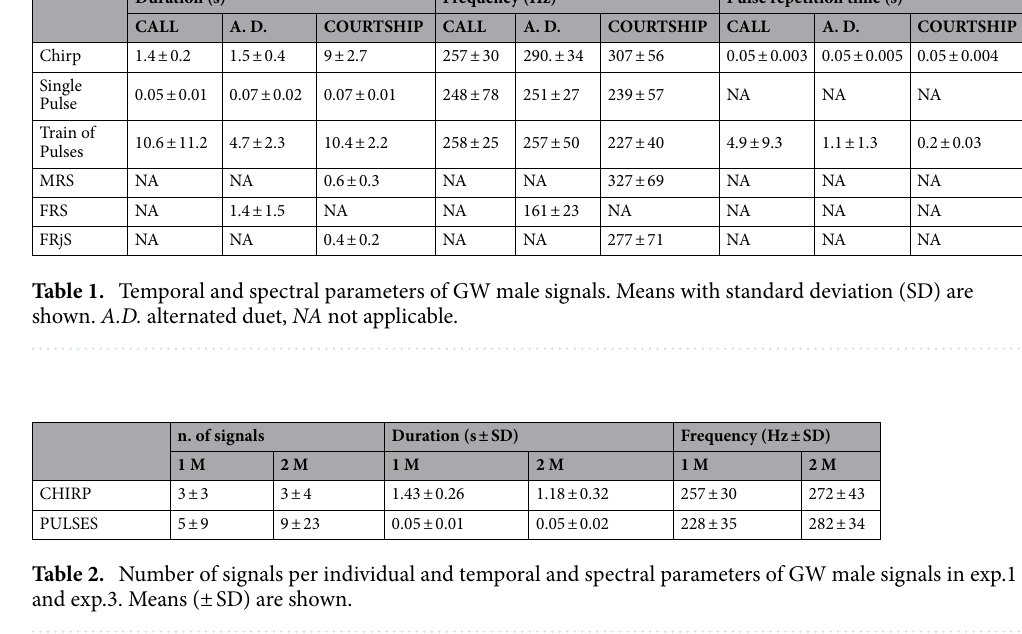
Duration (s) Frequency (Hz) Pulse repetition time (s)